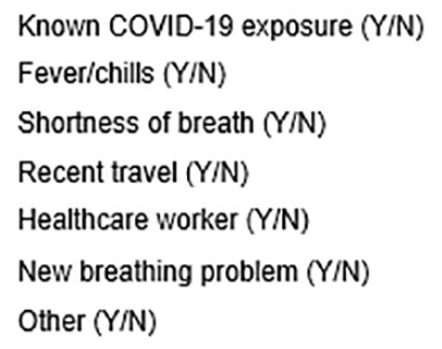
Figure 1. Dispatch screening questions.* *Yes to any question results in positive screen. Y , yes; N , no; COVID-19 , coronavirus